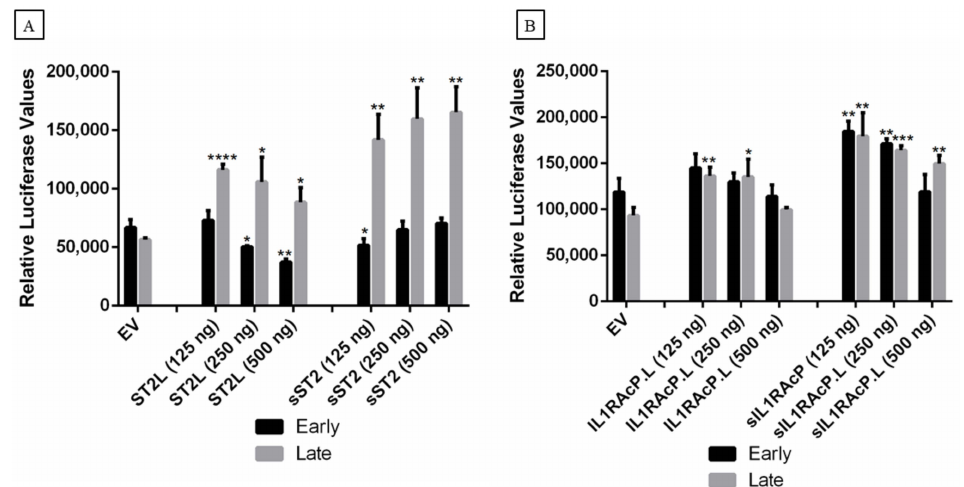
Figure 7. The effect of ST2/IL1RL1 and IL1RAcP on MCPyV promoter activity in MCC-13 cells. MCC-13 cells were transiently co-transfected with a luciferase reporter plasmid containing the early or late promoter of MCPyV and ( A ) ST2/IL1RL1 and ( B ) IL1RAcP expression plasmids, respectively. pcDNA3.1 was used as an empty expression vector (EV). Luciferase activity was measured at 24 h after transfection. Abbreviations: ST2L (membrane-bound ST2/IL1RL1), sST2 (soluble form of ST2/IL1RL1), IL1RAcP.L (membrane-bound IL1RAcP), sIL1RAcP (soluble form of IL1RAcP). Each bar represents the average of three independent parallels ± SD. * p ≤ 0.05, ** p ≤ 0.01, *** p ≤ 0.001, and **** p ≤ 0.0001.